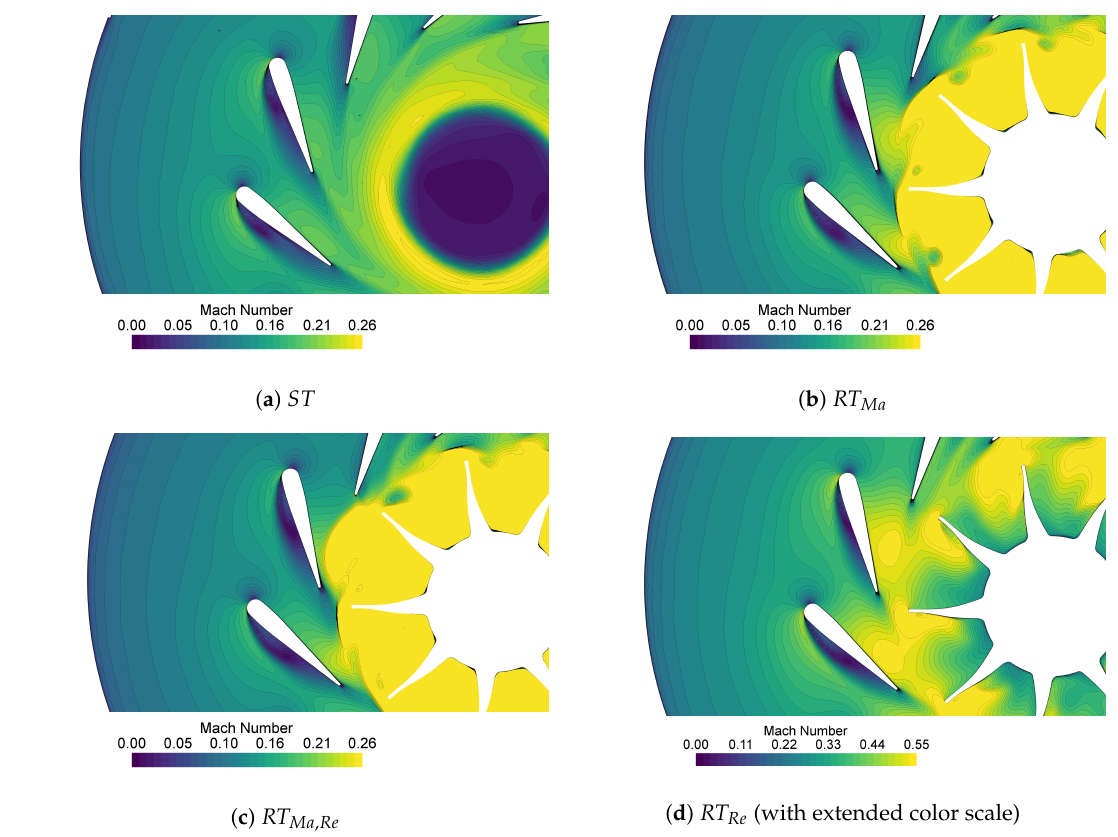
Figure 7. Mach number distribution at the stator